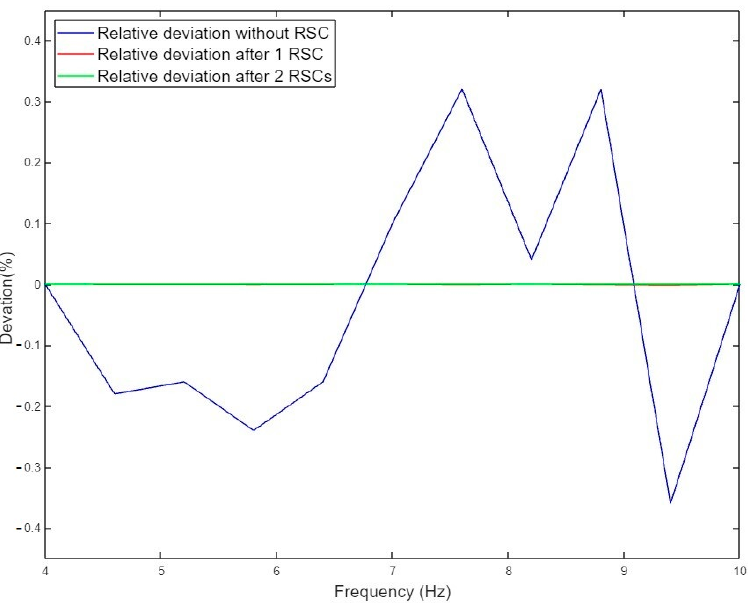
Figure 6. Improvement of DFS frequency measuring method using the RSC algorithm.